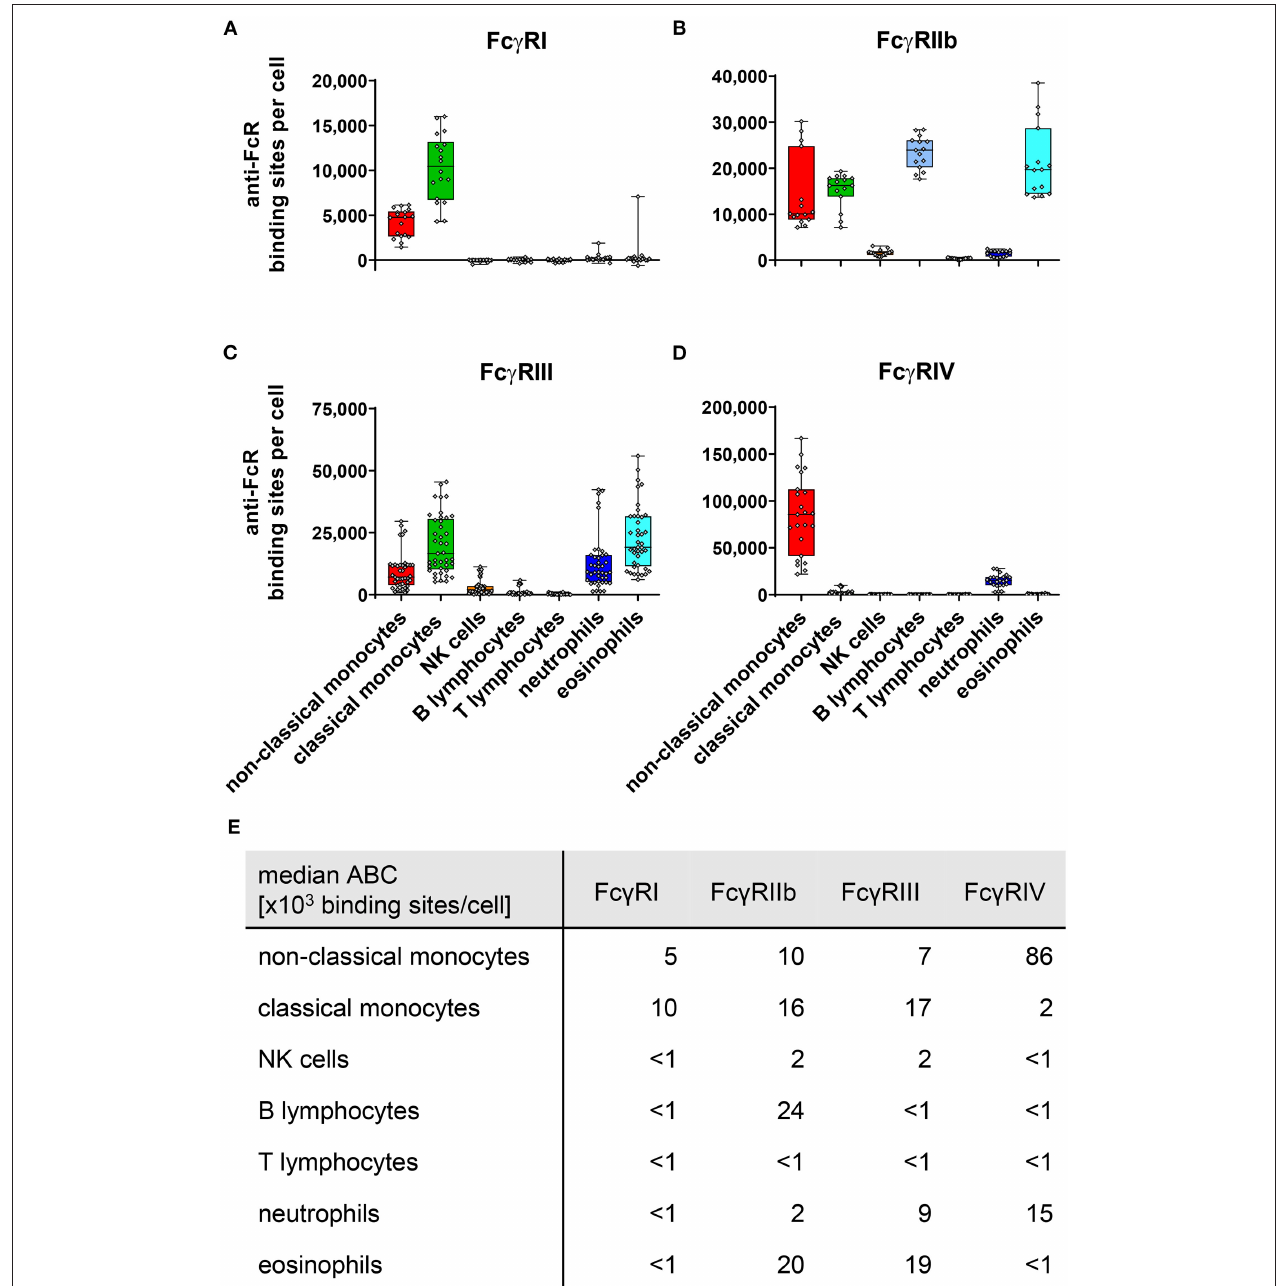
FIGURE 1 | Fc gamma receptors on murine peripheral blood leukocytes. Depicted are box plots showing anti-FcR binding sites for (A) Fc γ RI, (B) Fc γ RIIb, (C) Fc γ RIII, and (D) Fc γ RIV on indicated leukocyte subsets together with (E) a tabular presentation of the median number of binding sites. n = 15–41 from 4 to 11 independent